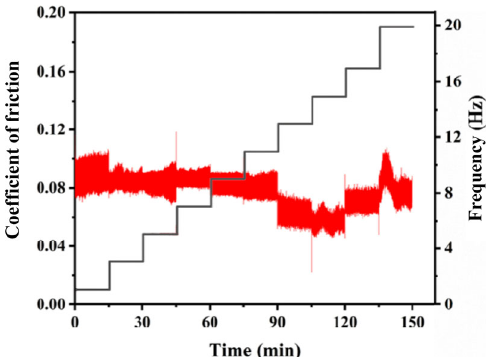
Fig. 11 Evolution of COF with time during a frequency ramp test from 1 to 20 Hz (load = 10 N, and the frictional test lasted 150 min) for OCPI-T100.